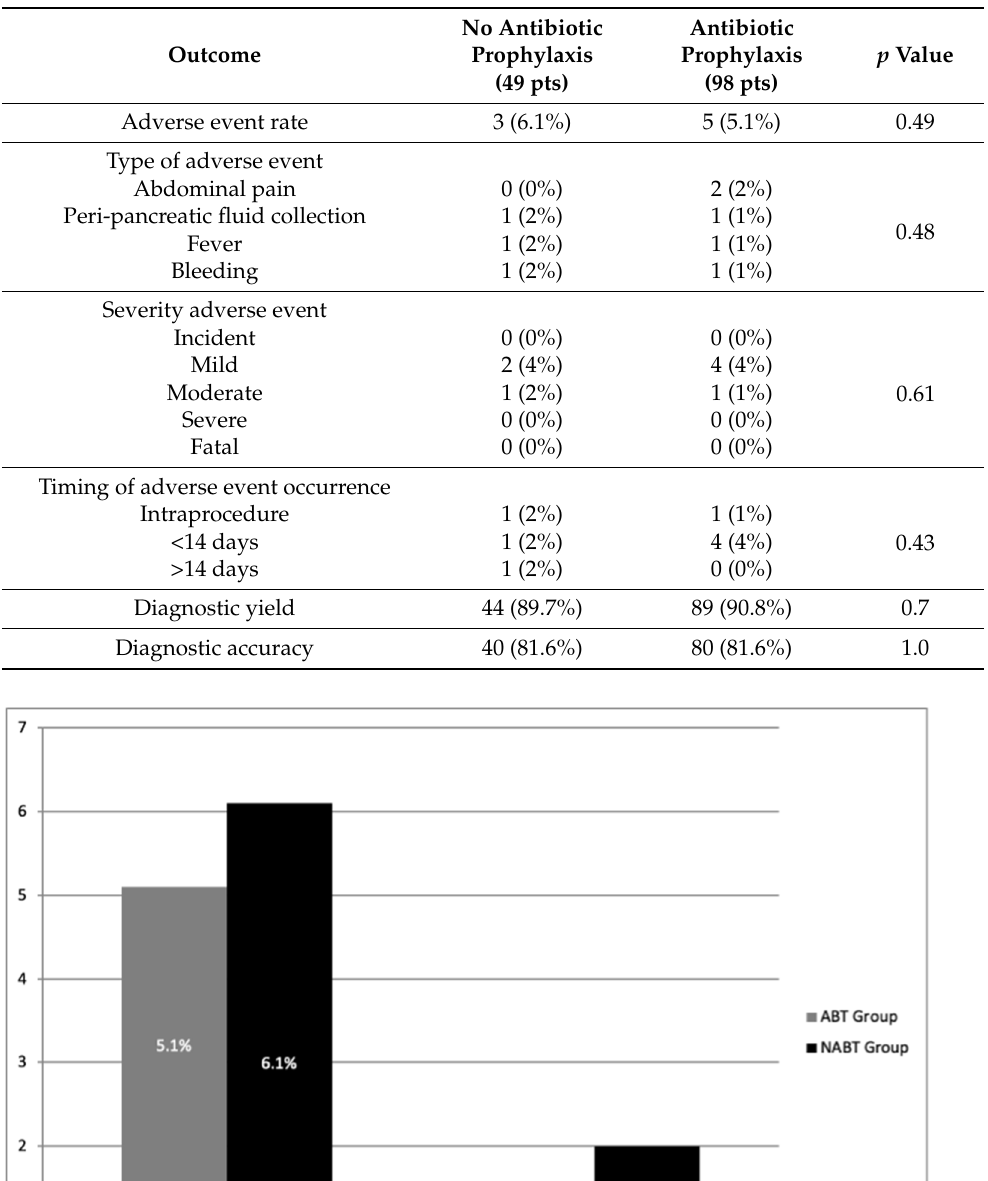
Table 2. Outcomes.